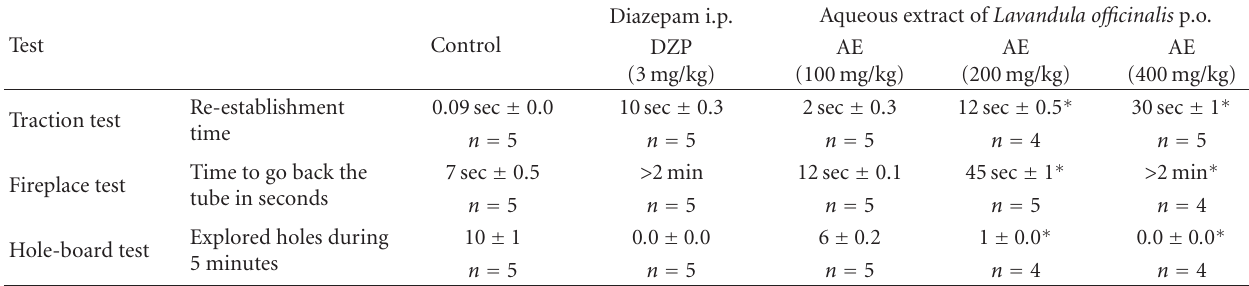
Table 2: Sedative e ff ect of aqueous extract of Lavandula o ffi cinalis. p.o. means oral route; i.p. means intraperitoneal route; n means number of mice per group; sec means seconds; AE means aqueous extract; DZP means diazepam. Data are expressed as mean ± SD; P < 0 . 001 versus the control group.